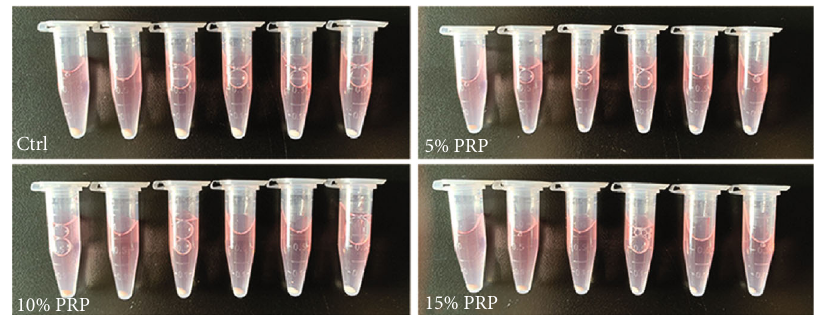
Figure 5: Gross morphology of BMSC pellets in four di ff erent media after 3-week culture in vitro .